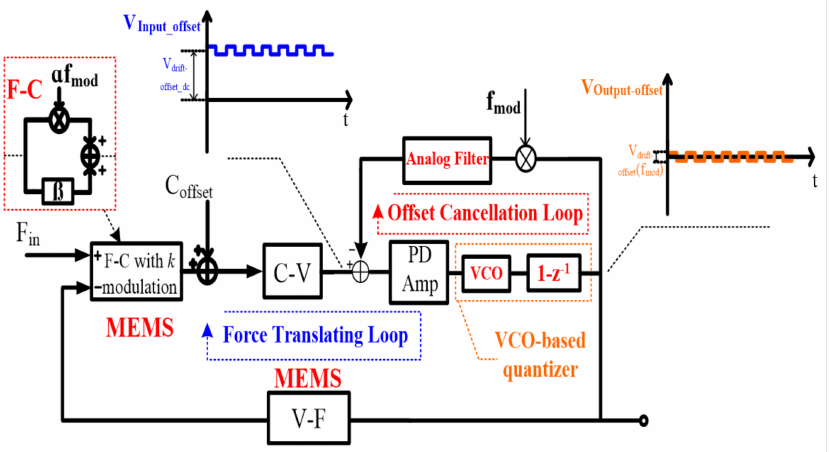
Figure 3. Illustration of the proposed